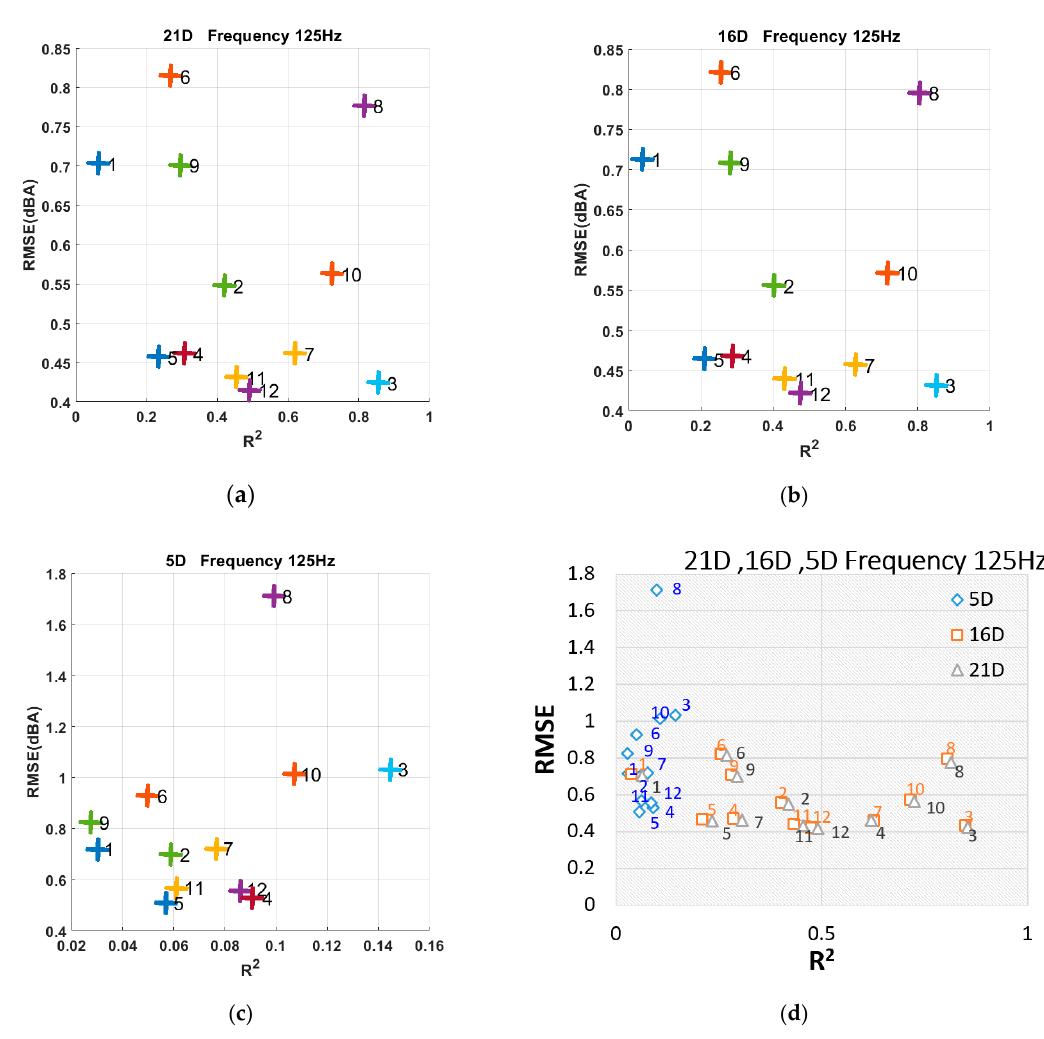
Figure 15. ( a ) Performance of input features set with 21 dimensions. ( b ) Performance of input features set with 16 dimensions. ( c ) Performance of input features set with five dimensions. ( d ) Performance of input features set with three combined kinds of different dimensions.